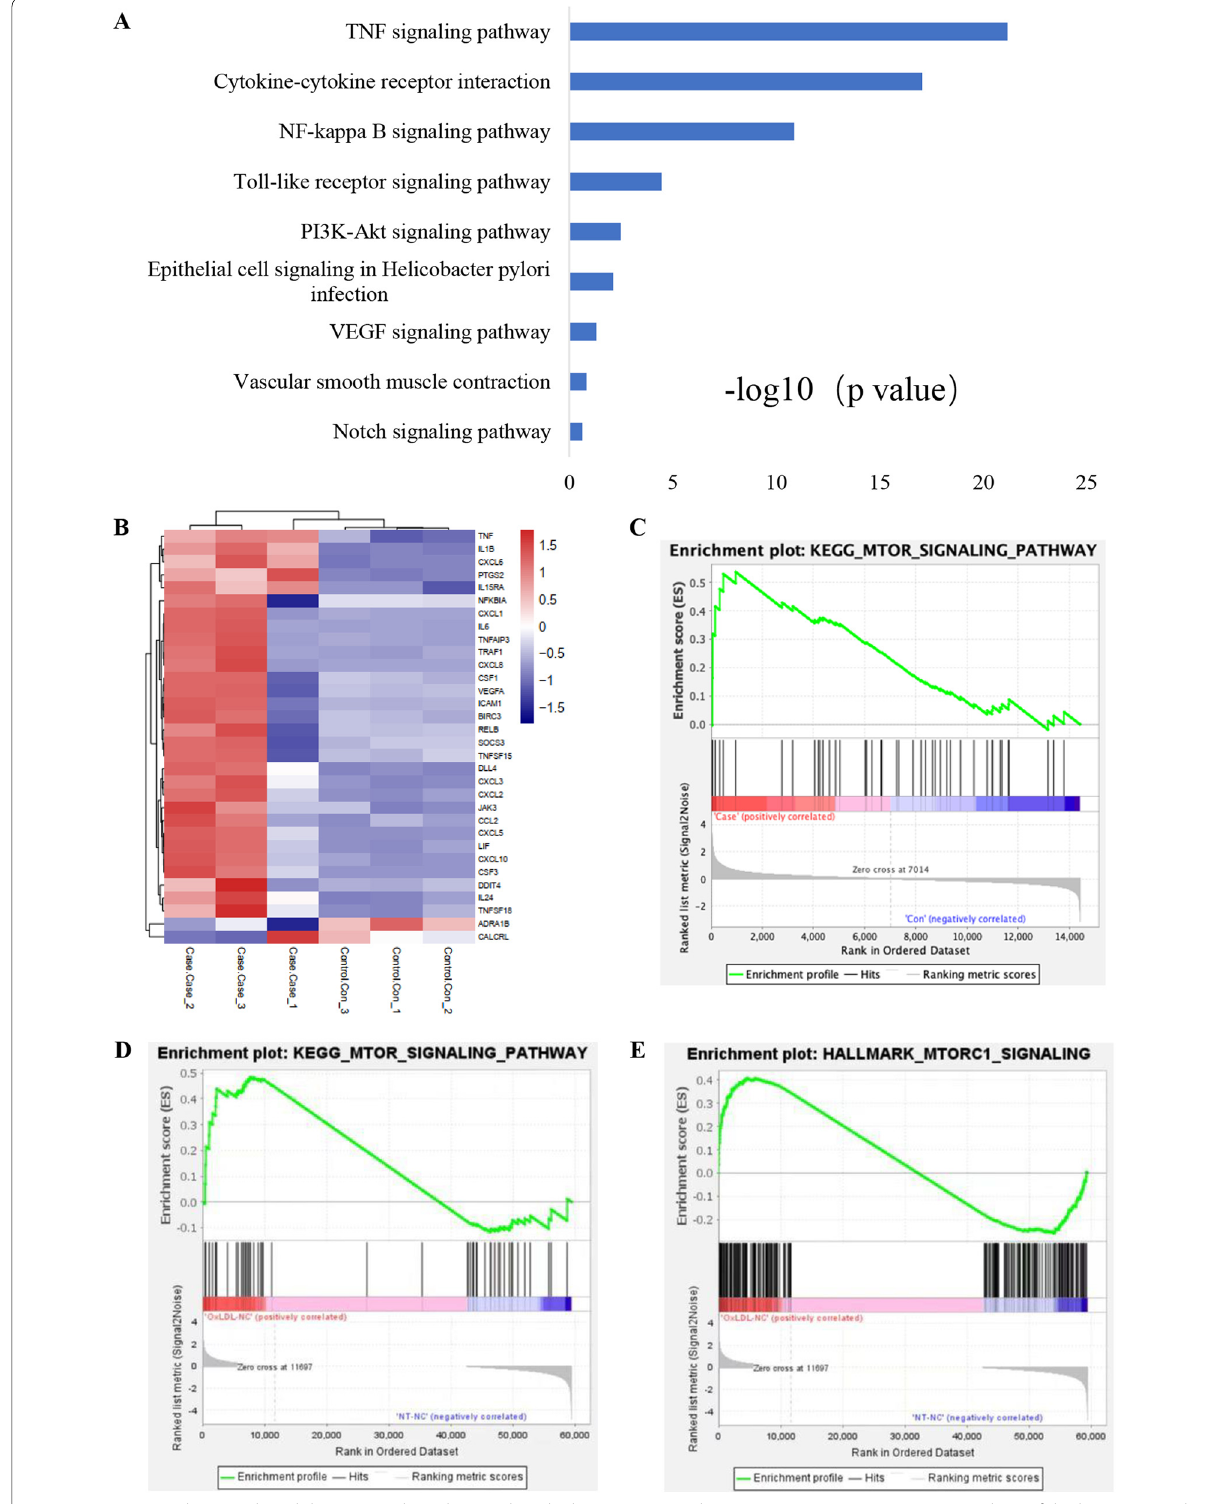
Fig. 5 RNA-seq analysis predicted the potential mechanism by which oxLDL upregulates VEGF-A expression. A KEGG analysis of the hEECs treated with oxLDL and PBS showed the possible signalling pathway involved in the process of oxLDL upregulating VEGF-A. B Heatmap analysis predicted that VEGF-A may be upregulated by oxLDL. C – E The GSEA plot shows that VEGF-A expression positively correlates with AKT-mTOR-activated gene signatures (MA_ENDOMETRIAL_EPITHELIAL_CELL, MINTA_VASCULAR_SMOOTH_MUSCLE_CELL,